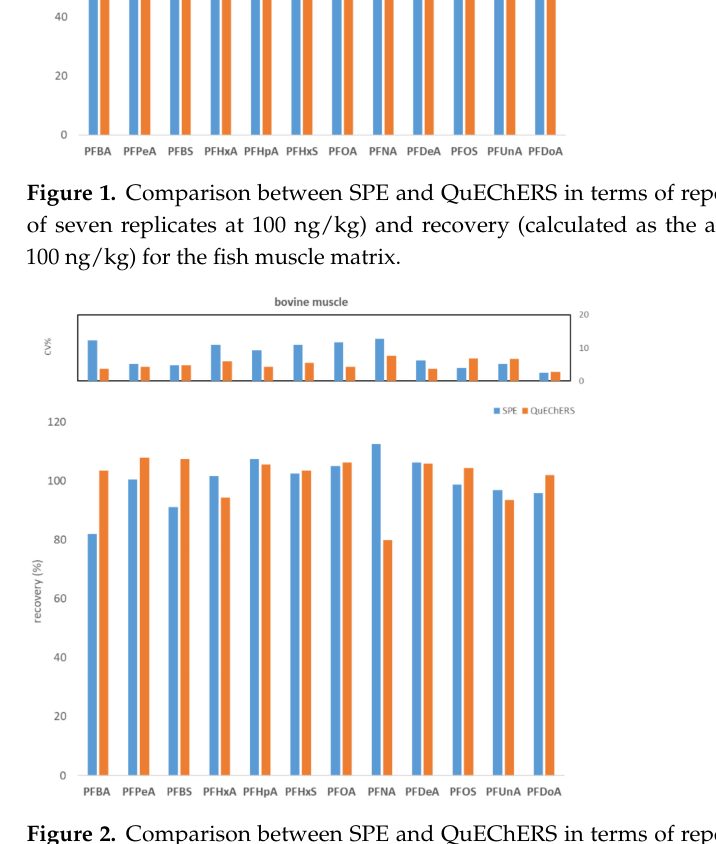
Figure 2. Comparison between SPE and QuEChERS in terms of repeatability (calculated as CV% of seven replicates at 100 ng/kg) and recovery (calculated as the average of seven replicates at 100 ng/kg) for the bovine muscle